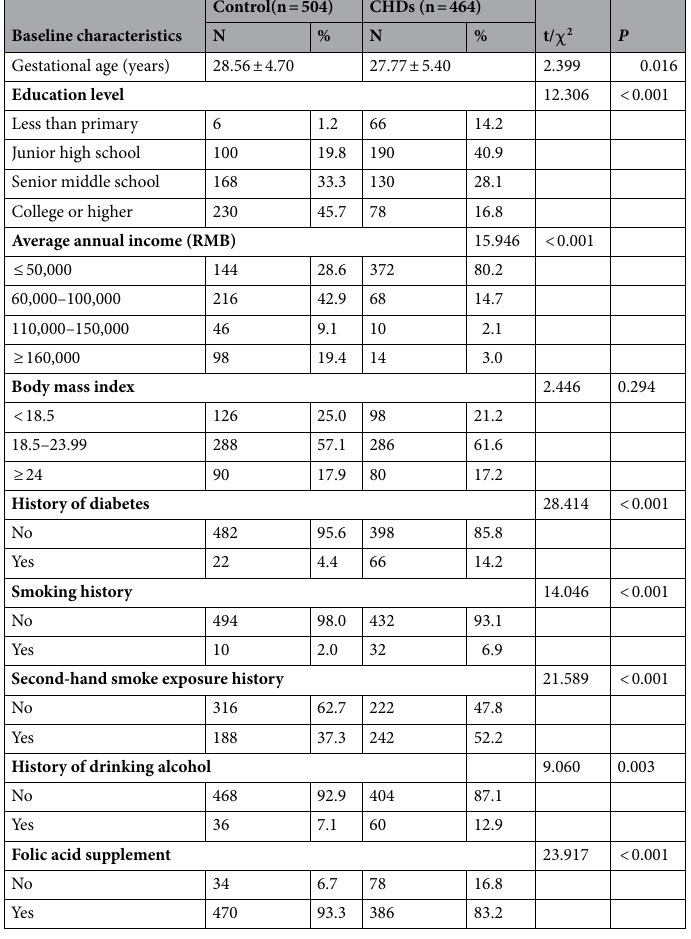
Table 1. Baseline characteristics in the case and control groups. CHDs congenital heart